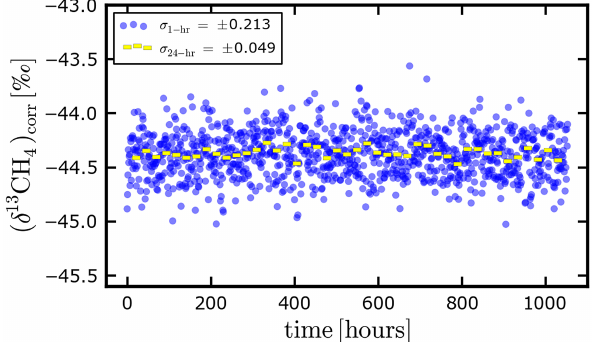
Figure 9. Hourly measurements of δ 13 CH 4 , after correction. The standard deviation of the hourly measurements (blue circles) and the daily measurements (yellow bars) are shown in the figure